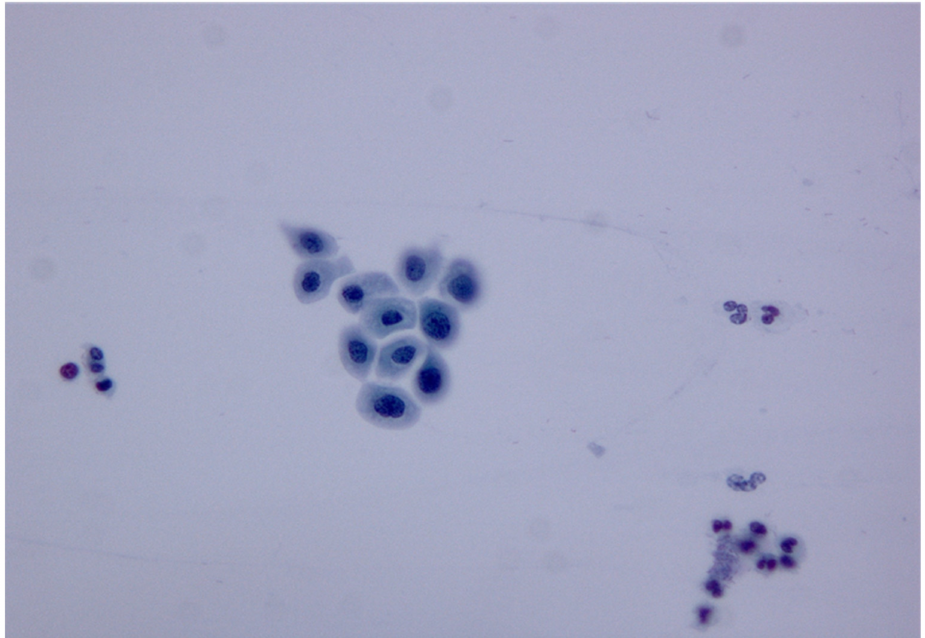
Figure 1. Cytology image of HSIL. Separated cells in a Pap smear presented typical features of high- grade dyskaryosis: slightly enlarged nuclei with hyperchromasia, increased nuclear/cytoplasmic ratios in most cells, and irregularly dispersed chromatin (magnification: 40 ×